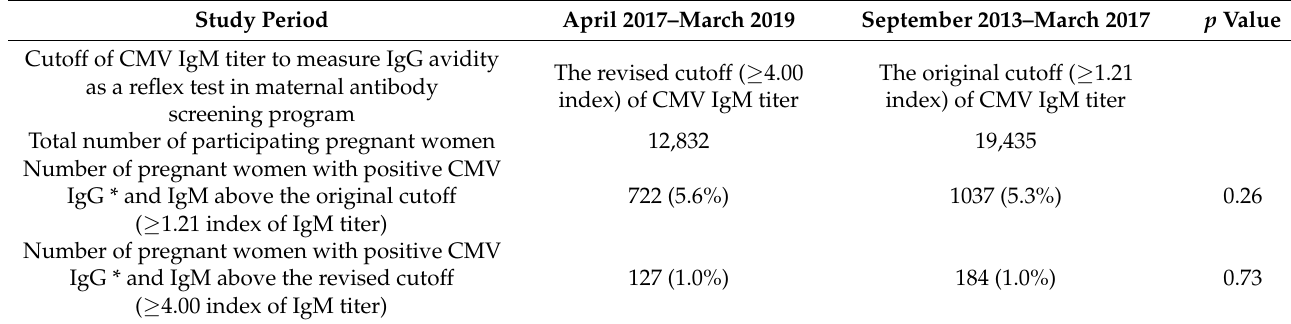
Table 3. Proportions of pregnant women with positive (including equivocal) CMV immunoglobulin (Ig) G and IgM above the revised ( ≥ 4.00 index) the original cutoff ( ≥ 1.21) among all pregnant women during the corresponding